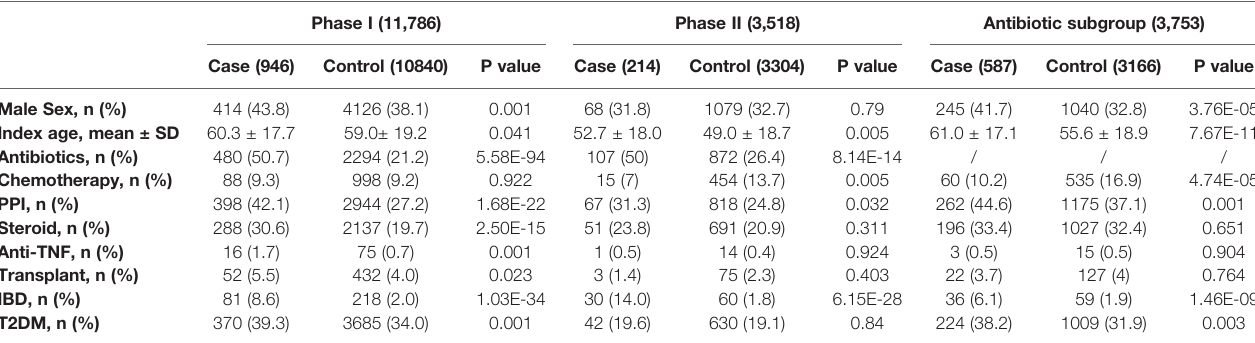
TABLE 1 | Demographics and clinical characteristics of cohorts from phase I, phase II and antibiotics subgroup for CDI